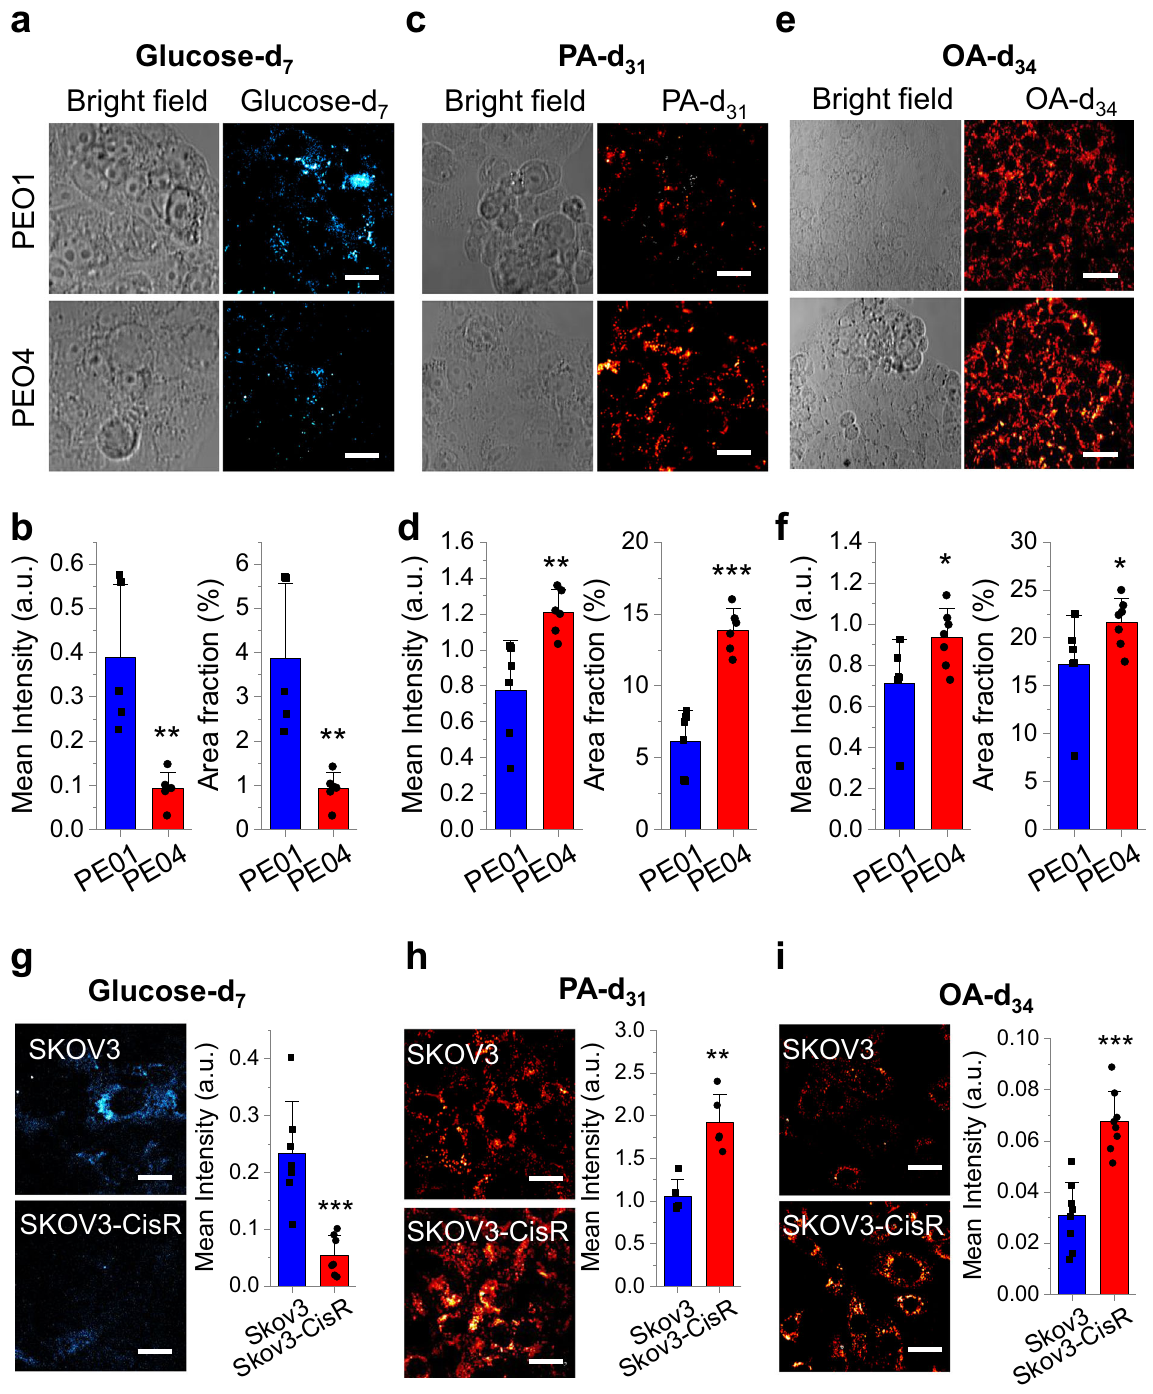
Fig. 2 | Increased FAuptake, not de novo lipogenesis, is the major contributor tolipidaccumulationincisplatin-resistantOCcells.a Representativebright fi eld and SRS images of PEO1 and PEO4 cells fed with glucose-d 7 for 3 days. b QuantitativeanalysisofSRSsignalofC-Dbondsinglucose-d 7 fedPEO1andPEO4 cells by mean intensity and area fraction. n =5. P =0.0076 and 0.0083. c Representativebright fi eldandSRSimagesofPEO1andPEO4cellsfedwithPA-d 31 for 6h. d Quantitative analysis of SRS signal of C-D bonds in PA-d 31 fed PEO1 and PEO4 cells by mean intensity and area fraction. n =6. P =0.0051 and 3×10 − 5 . e Representativebright fi eldandSRSimagesofPEO1andPEO4cellsfedwithOA-d 34 for6h. f QuantitativeanalysisofSRSsignalofC-DbondsinOA-d 34 fedPEO1( n =6) and PEO4 ( n =7) cells by mean intensity and area fraction. P =0.030 and 0.0048.